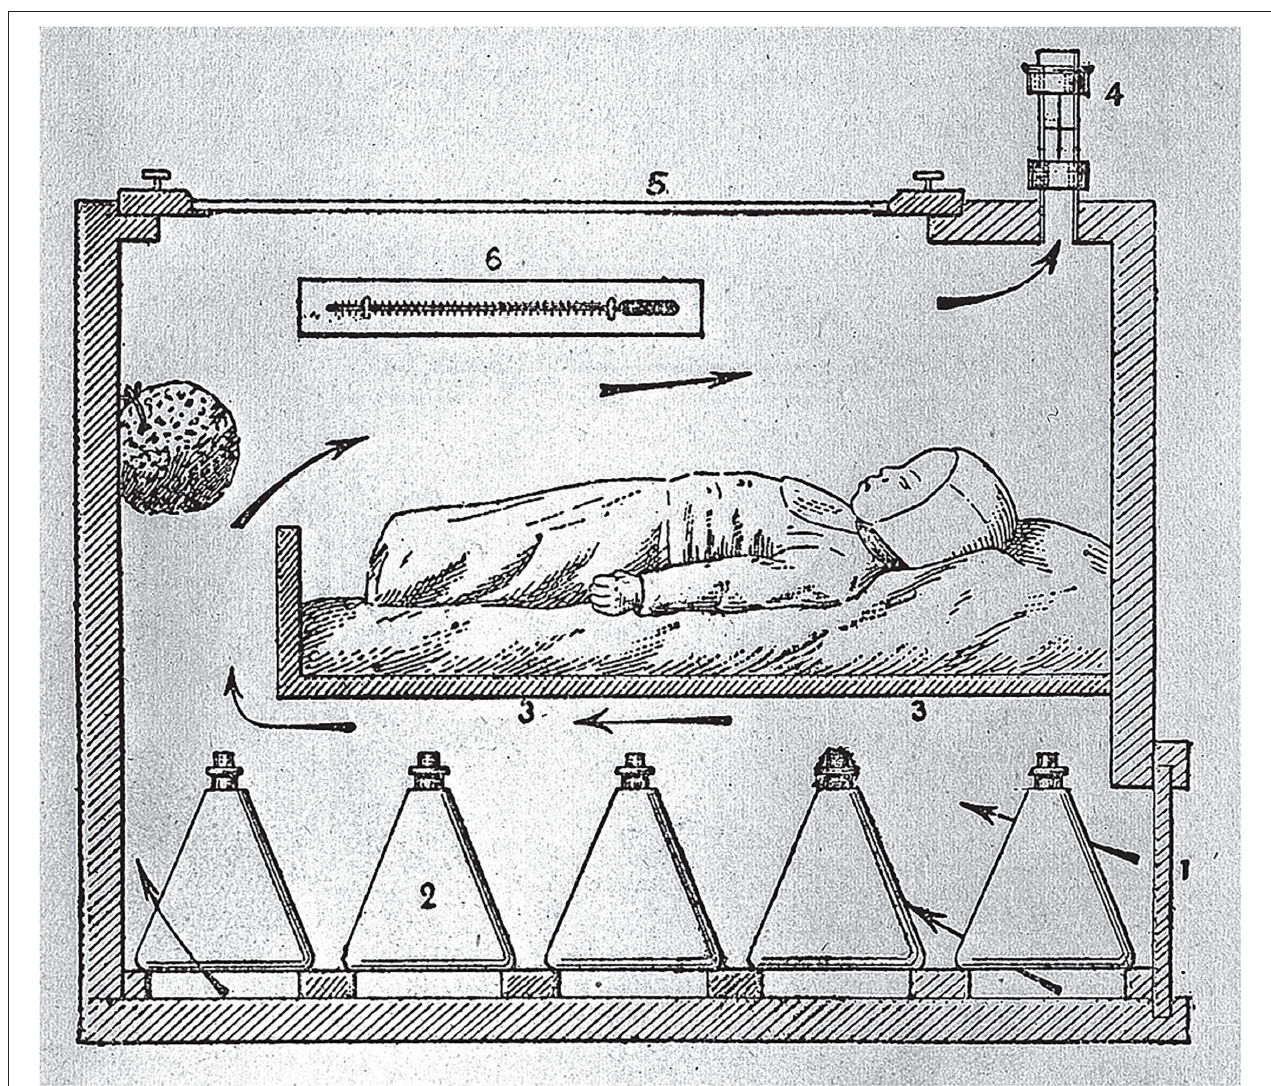
FIGURE 1 | Section of Tarnier’s Incubator. Retrieved from: https://commons.wikimedia.org/wiki/File:Section_of_Tarnier%27s_incubator;_Budin,_The_Nursling,_ 1907_Wellcome_L0005632.jpg. Arrows indicate the air flow.